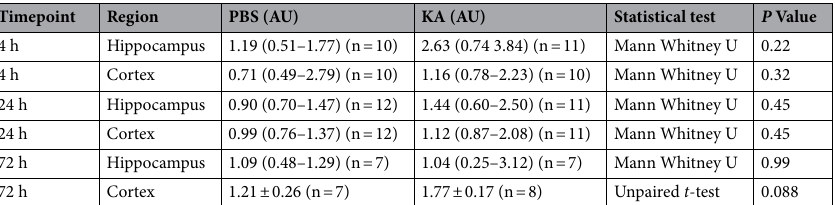
Table 1. Statistical details for miR-134 expression after status epilepticus (Fig. 3). Average values reported as Median (IQR) for non-parametric and mean ± SEM for parametric comparisons.